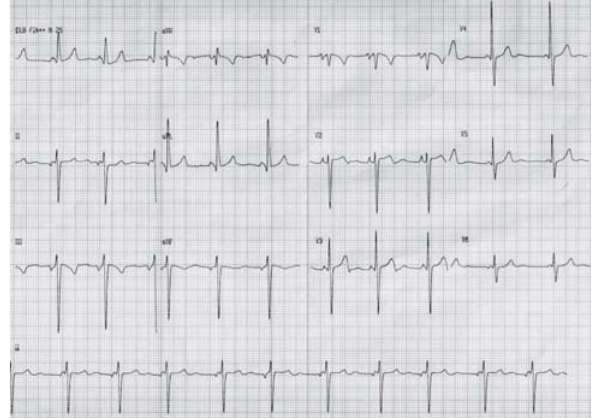
Fig. 1 – Eletrocardiograma prévio à operação tipo Fontan (cavopulmonar total) com ritmo atrial direito baixo e bloqueio divisional ântero-superior